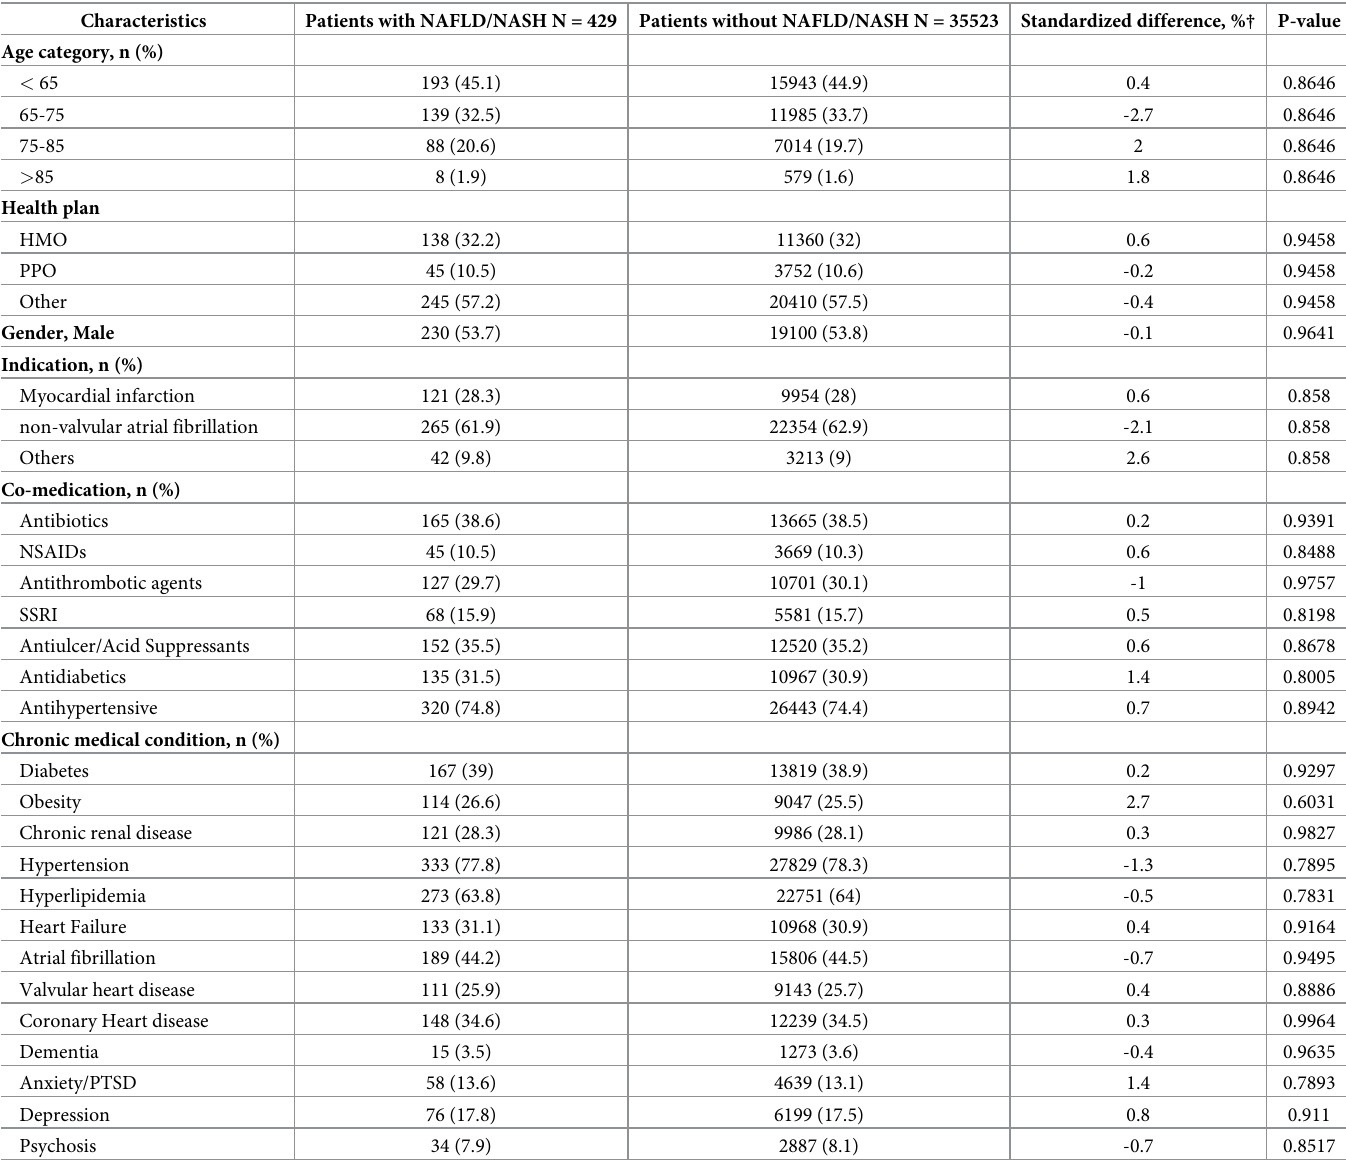
Table 2. Demographic and clinical characteristics using propensity score fine stratification, USA 2010 – 2015.